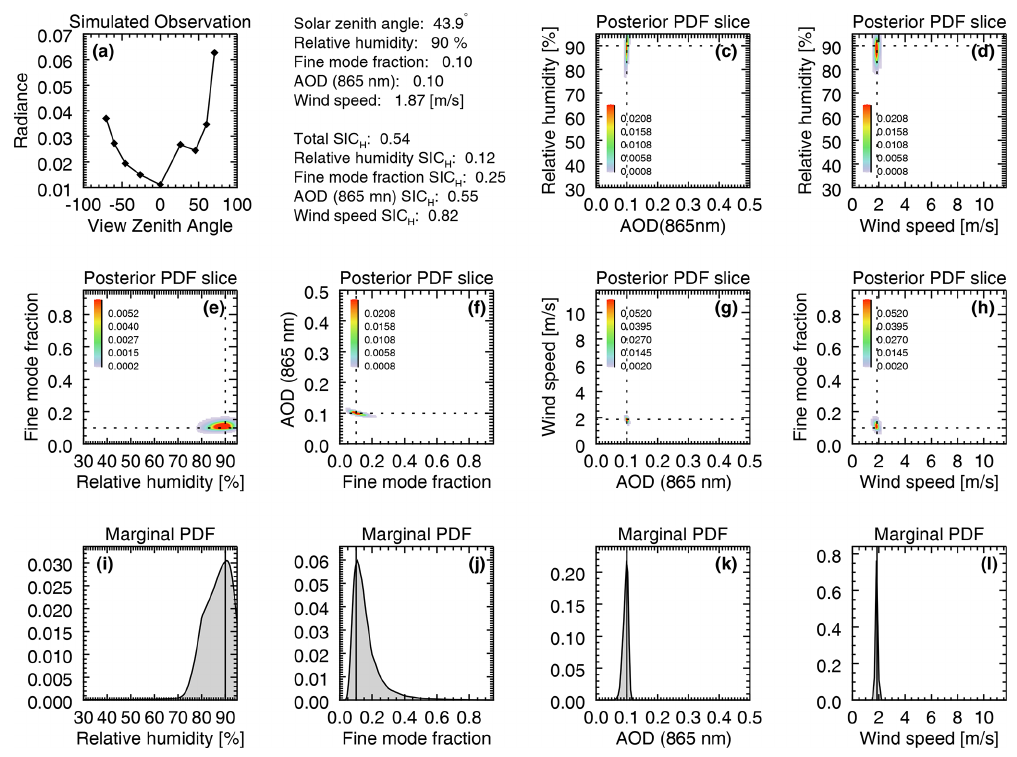
Figure 3. GENRA results for a successful retrieval, whose overall SIC R = 0 . 54. The geometry for this scene is for test case G, which had a θ s = 43 . 9 ◦ , with r = 90%, f = 0 . 10, τ = 0 . 10, and w = 1 . 87ms − 1 . Marginal PDFs for each of those parameters are shown in panels (i) , (j) , (k) , and (l) , respectively, and solid vertical lines in those plots indicate simulated parameter value. Slices through a posteriori space are in panels (c) , (d) , (e) , (f) , (g) , and (h) , where dashed lines indicate the value of the LUT node under investigation. Panel (a) contains the simulated